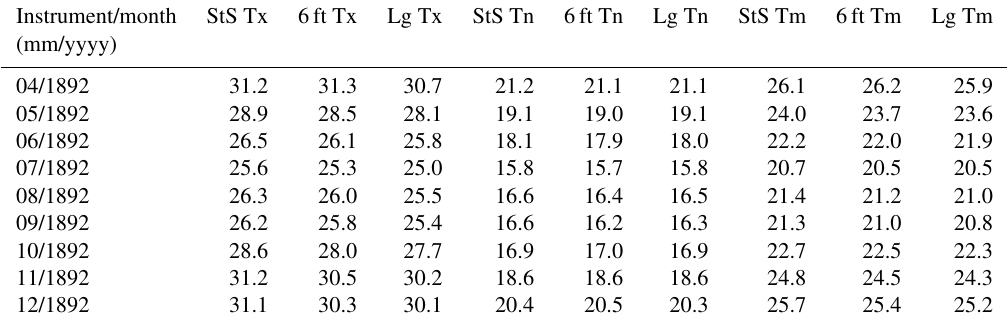
Table 3. Comparison of the three Stevenson screen set-ups undertaken in the latter part of calendar year 1892. Original values in ◦ F have been converted here to ◦ C. StS stands for the standard long-running Stevenson screen measurements – taken at a height of 4ft (1.2m). The 6ft screen is mounted instead at 6ft (1.8m), which is closer to the typical range of screens today that tend to be at 1.5 to 2m. Lg refers to the larger screen size, which is perhaps more comparable to the size of today’s screens. The size of the two standard screens has not been able to be ascertained from the available metadata (see Sect.